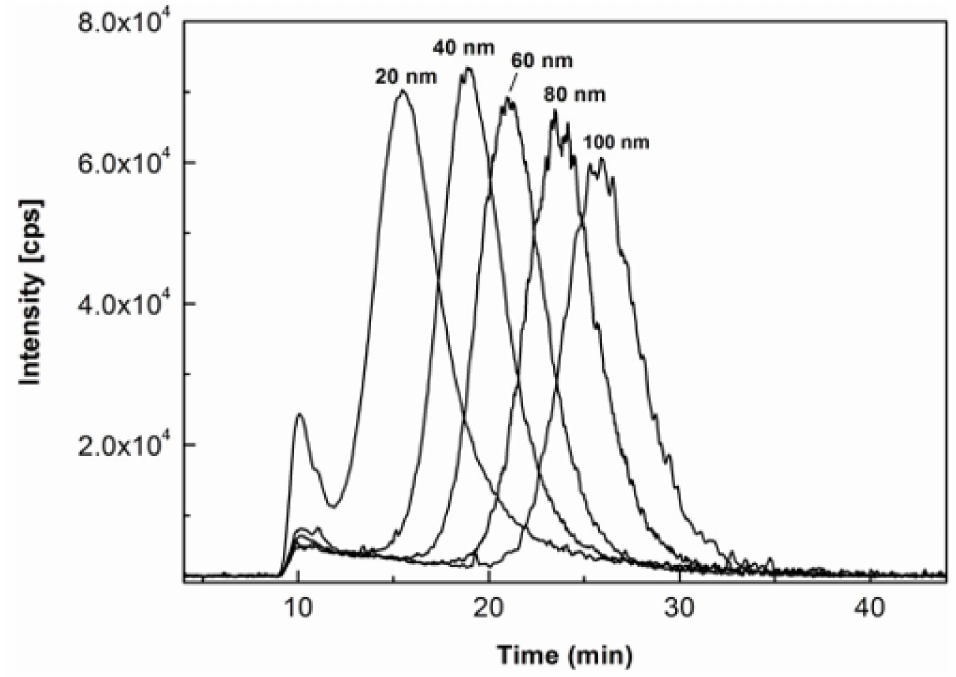
Figure 4. Overlaid AF4-ICP-MS fractograms of AgNPs standards (size-ladder) spiked into milk at 285 µ g/L for each with enzymatic digestion at 36 ◦ C for 6